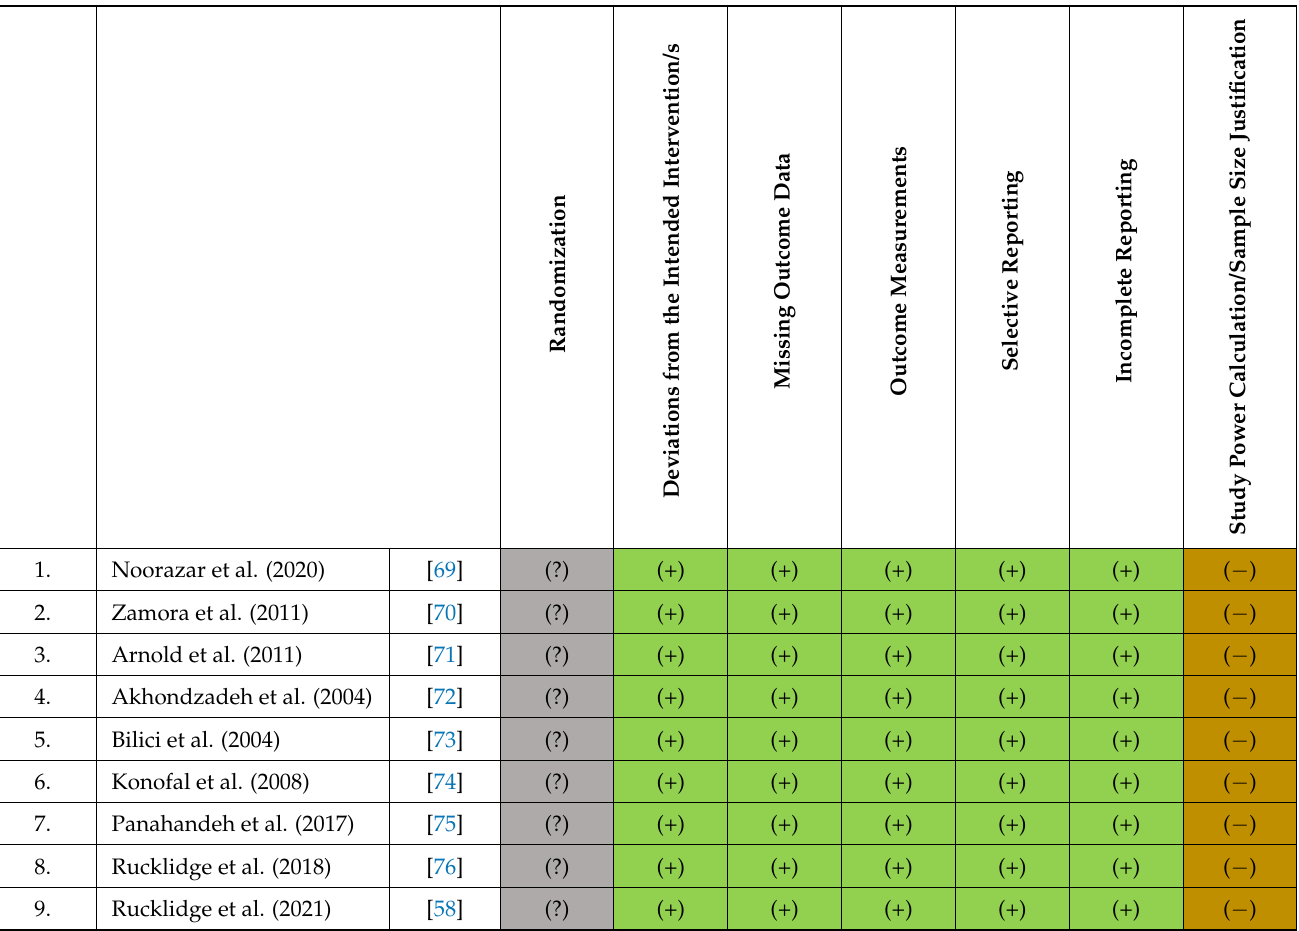
Table 5. Assessment of the risk of bias based on the Cochrane Risk of Bias 2